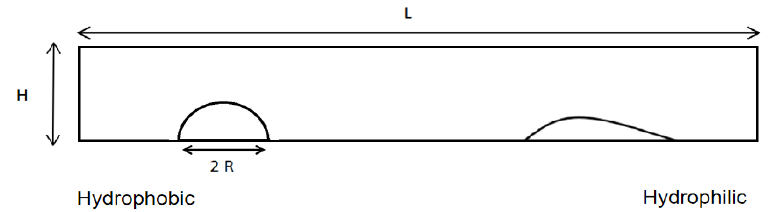
Figure 1. The computational domain of the simulation. Semicircle: The droplets move from the superhydrophobic side to the hydrophilic side.